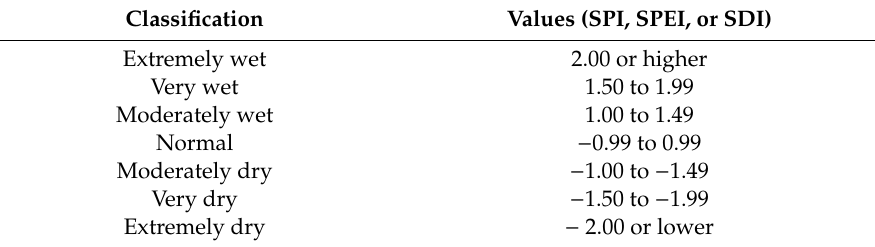
Table 2. Classification of drought